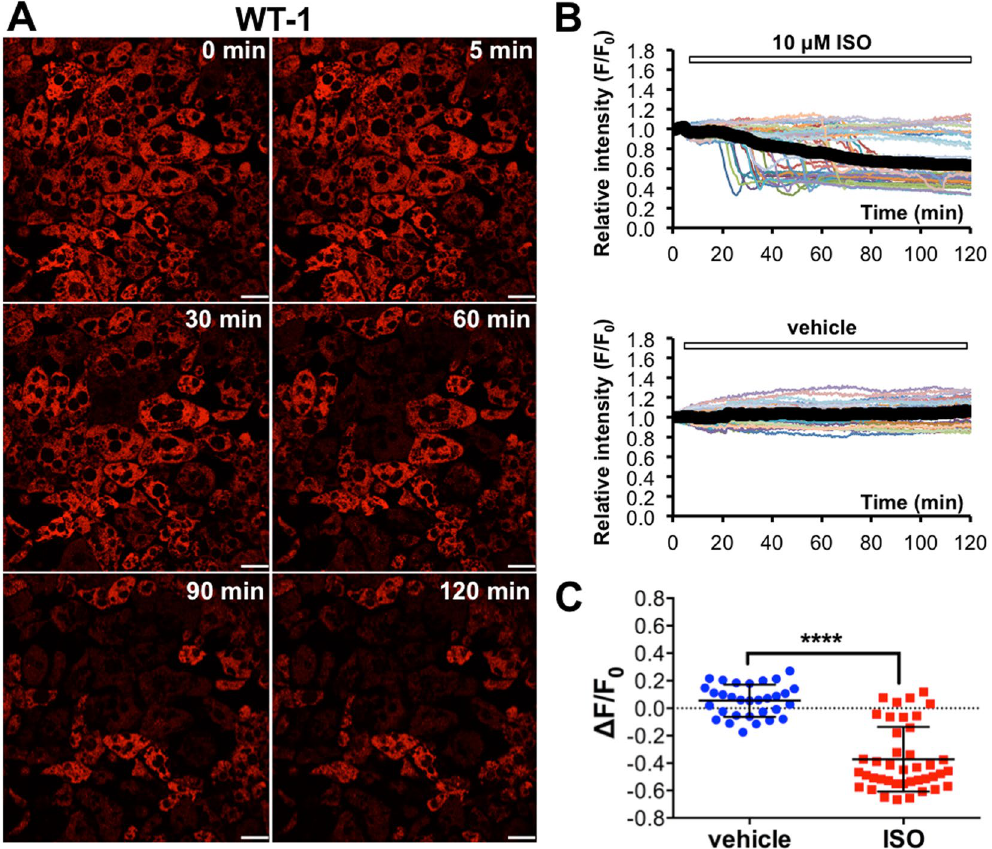
Figure 2. ERthermAC shows robust temperature changes after isoproterenol stimulation in WT-1 cells. ( A ) Individual ISO-stimulated WT-1 cells exhibit decreased ERthermAC fluorescence intensity, suggesting a robust increase in temperature. For time-lapse videos, see Supplementary Video 1. Scale bar: 20 µ m.( B ) Quantitative analysis of ERthermAC fluorescence intensity after ISO and vehicle stimulation: individual WT-1 cells exhibit a rapid decline in relative intensity after ISO stimulation. The reductions in fluorescence intensity occur at different time points in individual cells. In contrast, vehicle stimulation does not affect ERthermAC intensity. Thick black curves correspond to the mean relative intensities in each group. ( C ) Scatter plot of ERthermAC relative intensity change shows a significant difference in WT-1 cells. Bars show mean ± SD. WT-1 vehicle: n = 31 cells from 2 cultures; WT-1 ISO: n = 41 cells from 2